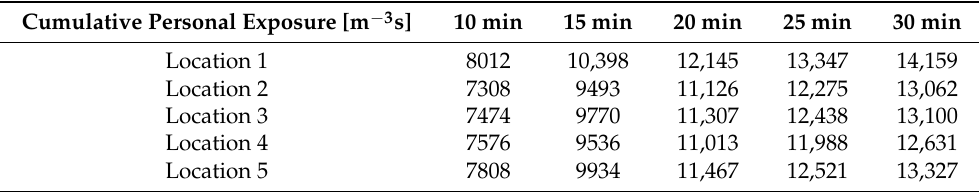
Table 1. Cumulative personal exposure to particles from the simulation results for five different locations in the room.